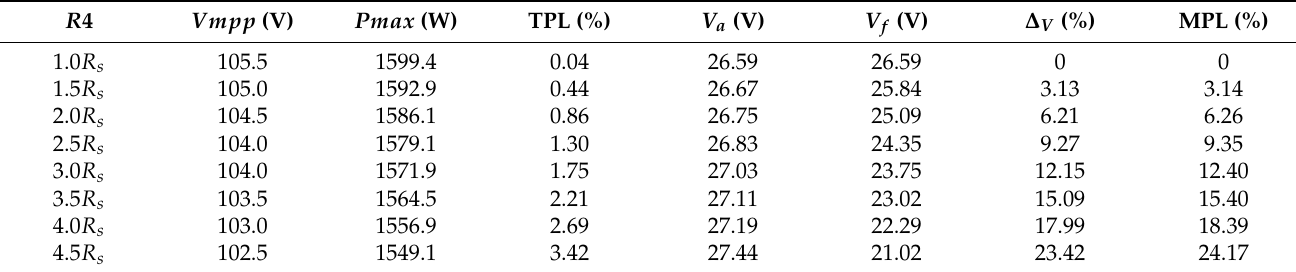
Table 5. Numeric results for the increment of R4 in the 4 × 2